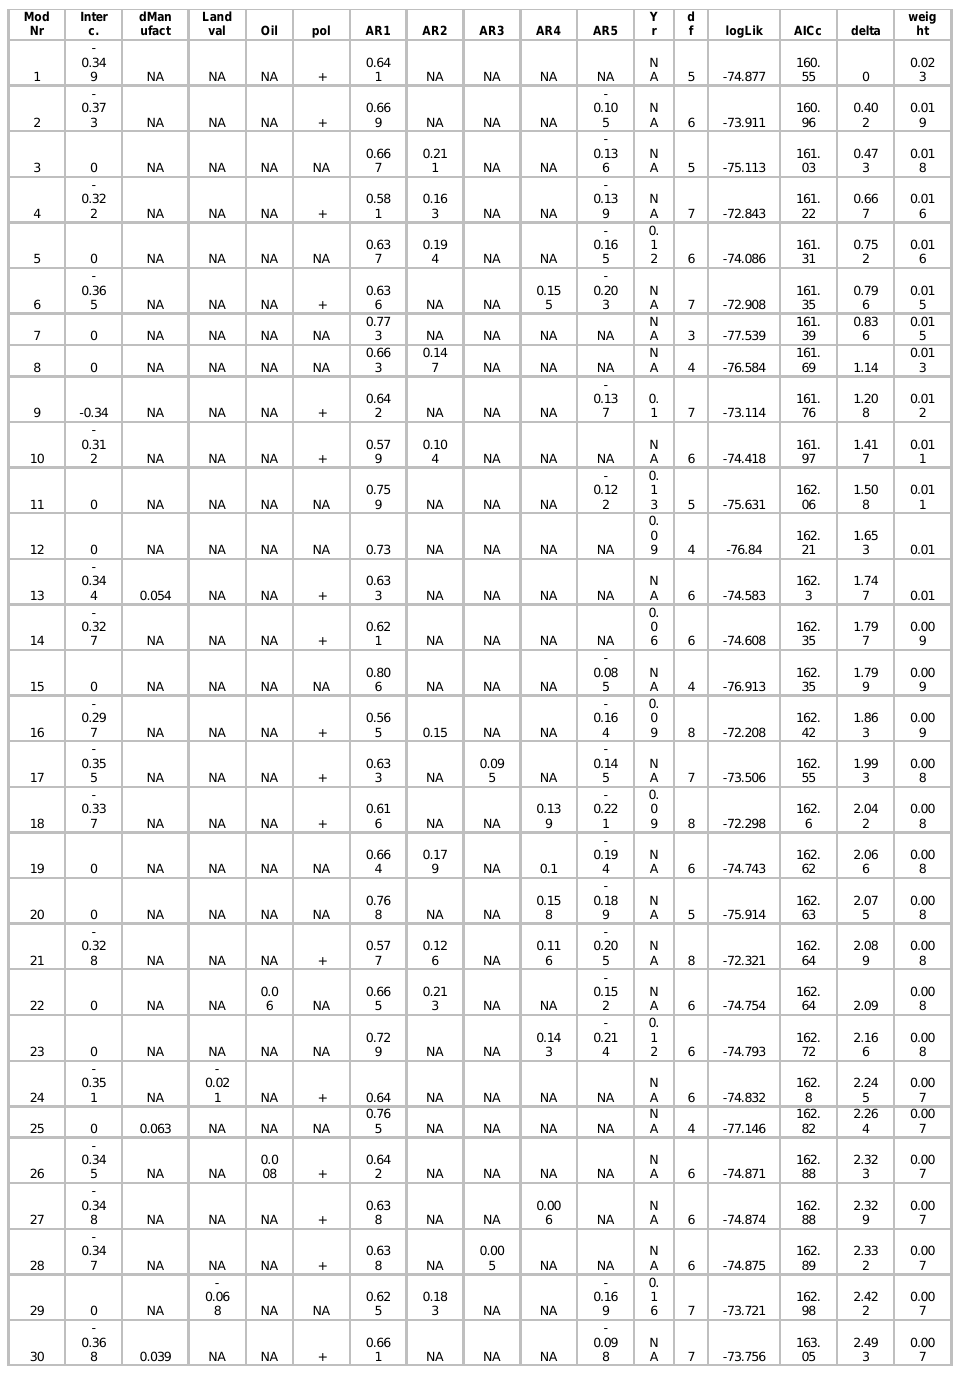
Table A1.5. Model selection table for statistical models explaining subsidy colour (fraction beneficial to capacity enhancing subsidies) for 1914-1994. Average parameter values calculated from weighting all models are given in Table A1.7. Only first 30 models